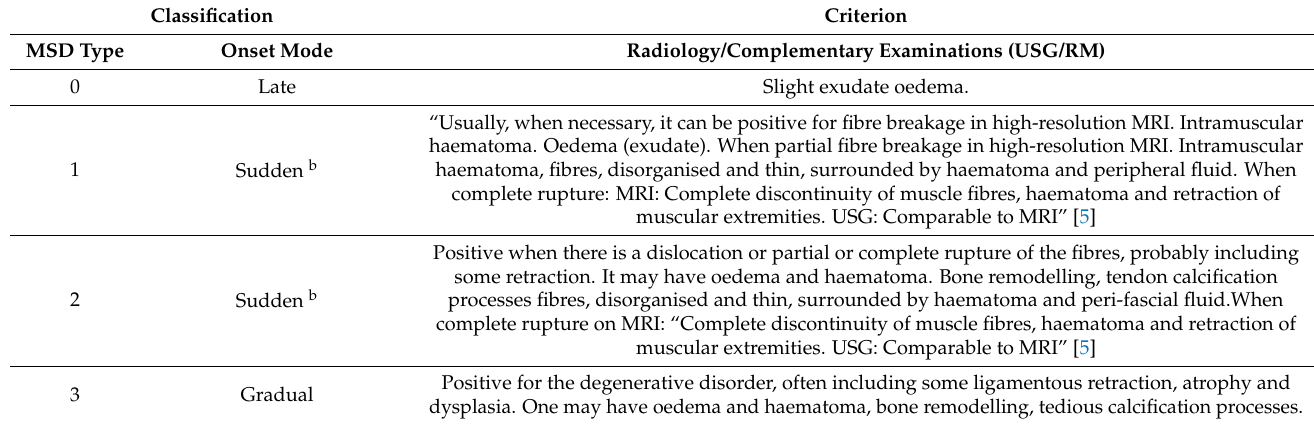
Table 5. Classification according to Radiological findings criteria (Adapted) [2,3,5,6].